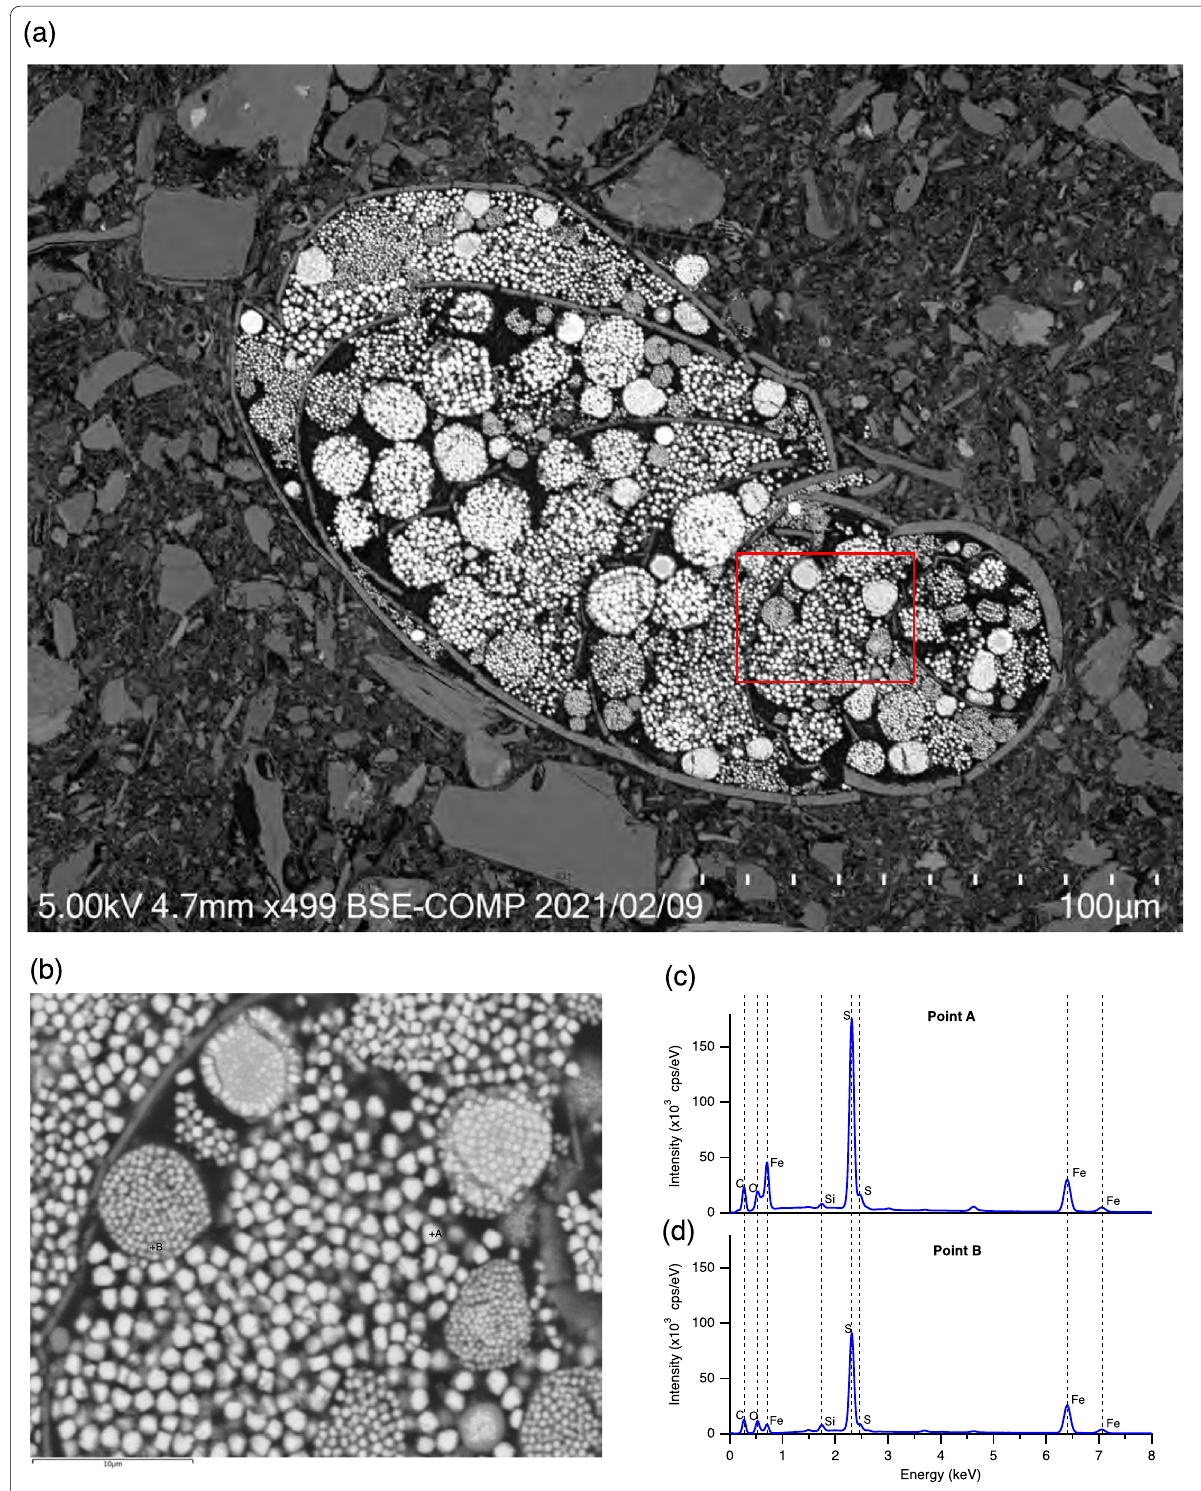
Fig. 2 SEM analyses on framboidal sulfides. a Back scatter electron image taken for a thin section from Sample 83A. Framboidal sulfide minerals are densely filling the chambers of foraminiferal shell. b Close up of the area in a shown by a red rectangle. Framboidal sulfide minerals were composed by coarse (~ 1 micro-m) and fine (~ 0.3 micro-m) grain-size. c and d are spectrum of point A (coarse grain) and B (fine grain) with characteristic peaks of Fe and S,